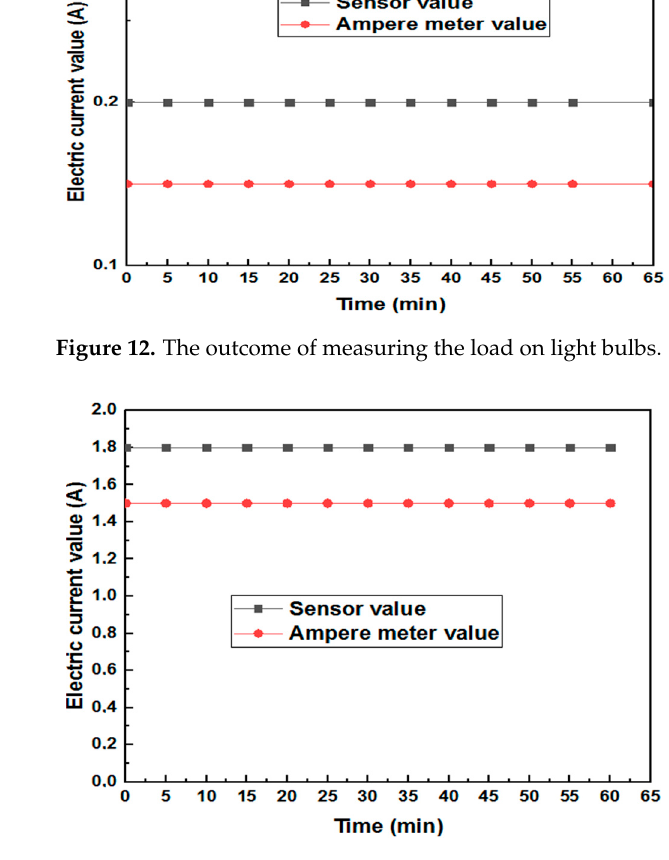
Figure 13. The outcome of measuring the load on a rice cooker.